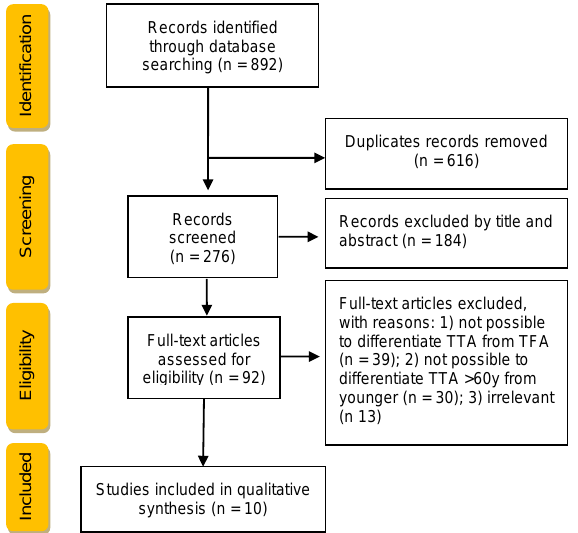
Figure1: Flowchart summarizing the study selection